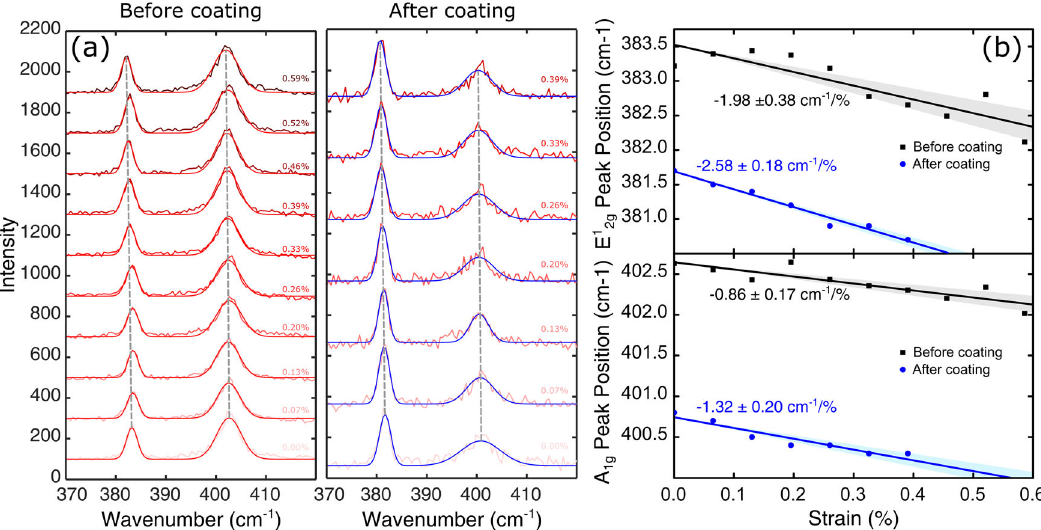
Fig. 7 Strain tunable Raman. a Raman spectra acquired for different uniaxial strains on a single-layer MoS 2 fl ake before and after adamantane plasma polymer encapsulation. b E 1 2g and A 1g peak positions as a function of uniaxial strain before and after encapsulation. The data has been fi t to a straight line to extract the gauge factor value (solid line). The shaded area around the solid line indicates the uncertainty of the fi t.